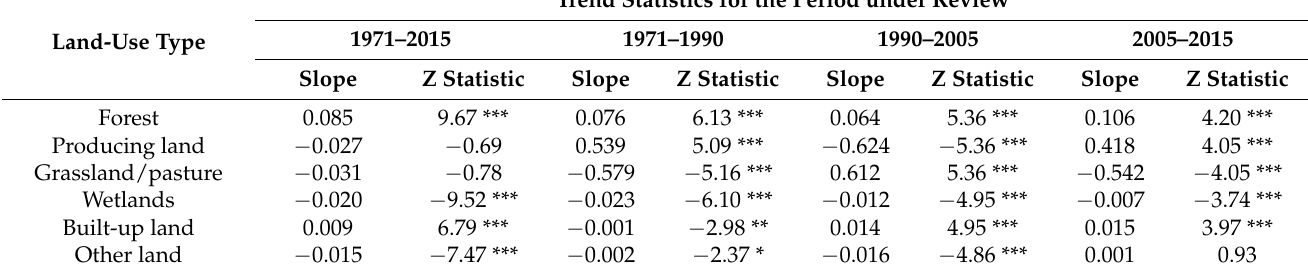
Table 1. Trends of change in proportion of land-use types across the whole of Lithuania (significance level of slope: ***, 0.001; **, 0.01; and *, 0.05).